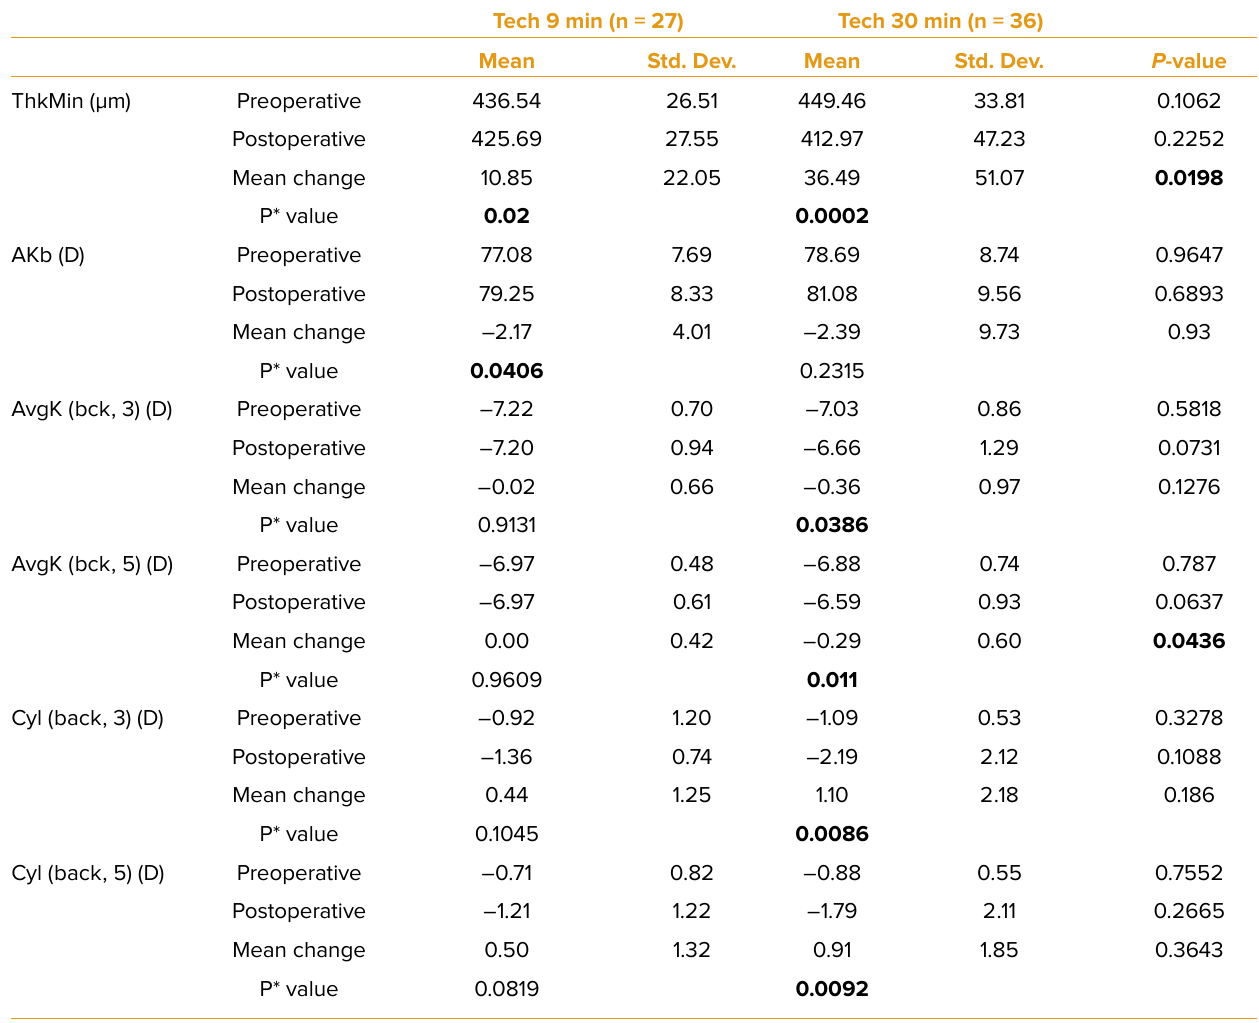
Table 3. Pachymetry, posterior corneal keratometries, and astigmatism